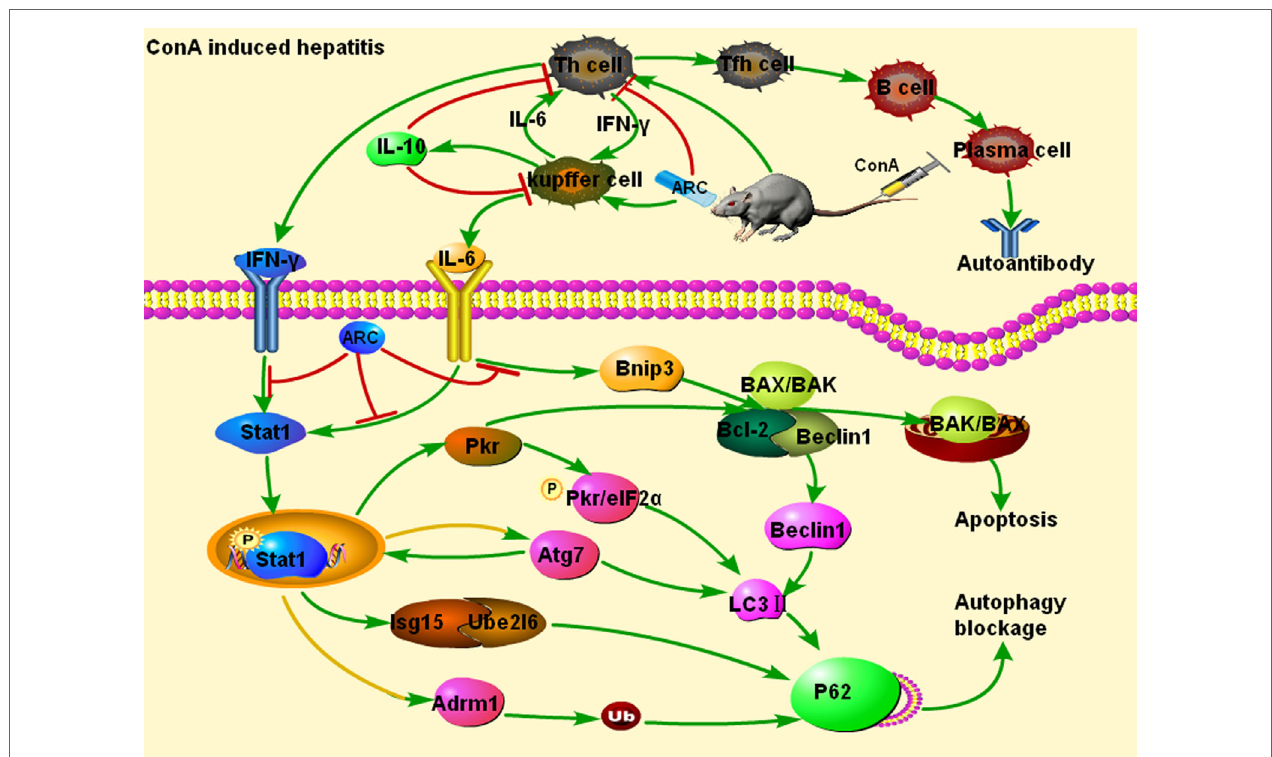
FigUre 10 | Protective mechanism of ARC on ConA-induced hepatitis. ARC exhibited protective effects through decreasing the levels of pro-inflammatory IFN- γ and IL-6, and increasing the ones of IL-10. The upregulations of Atg7, Beclin 1, and Pkr induced the increase of the expression of LC3 II. The Adrm1, Isg15, Ube2l6, and LC3 II led to the increased expression of p62. ARC pretreatment inhibited autophagy as well as apoptosis by suppressing IFN- γ /IL-6/Stat1 signaling and IL6/ Bnip3 signaling. But, whether the upregulations of Atg7 and Adrm1 depend on Stat1 need further study. The green arrows represent activation, the red lines represent inhibition, and the yellow lines with green arrows represent the predictive